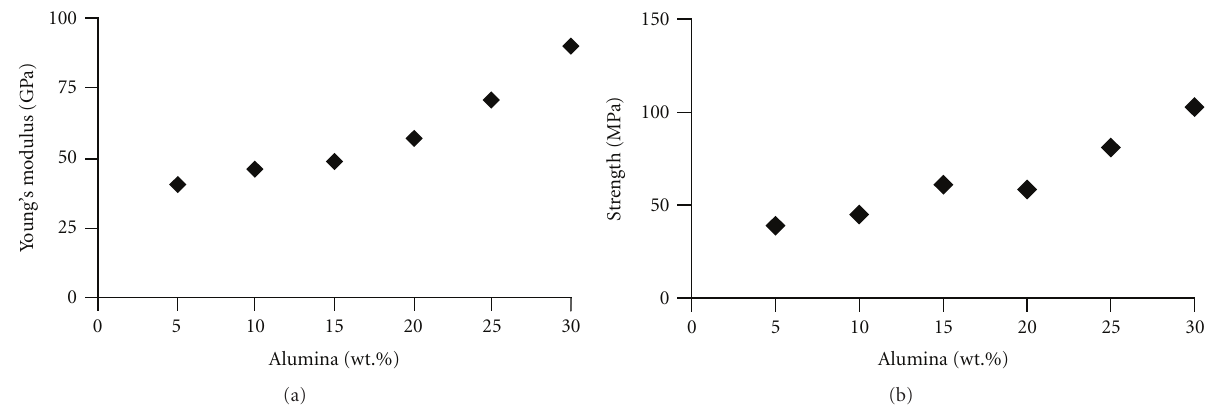
Figure 7: Young’s modulus (a) and fracture strength (b) of nickel-alumina composites as a function of ceramic content (wt.%).